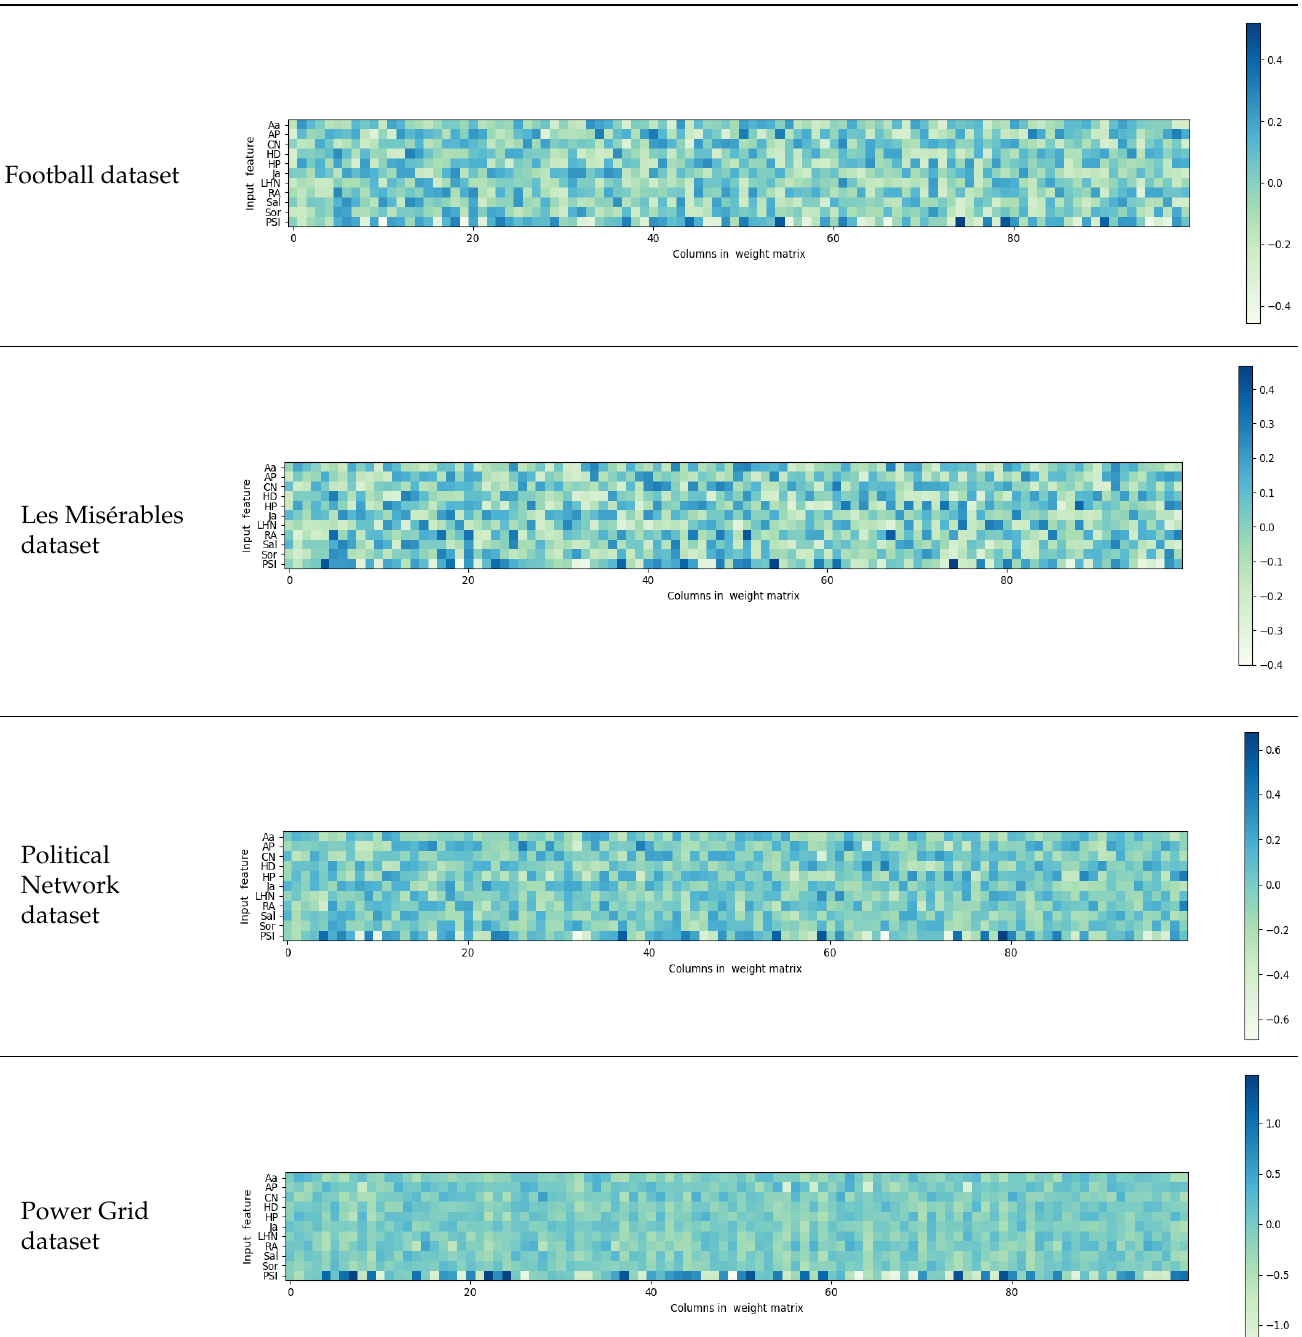
Table 10 represents the weights of every hidden unit. The blue area represents large positive values, while the white area represents negative values. For every dataset, if the color of cells are darker, this means that the used parameter is important to the process. We notice that, for most of the datasets, our proposed metric has the darkest row. Thus, it plays a role in the decision-making process. Table 10. Results of the neural